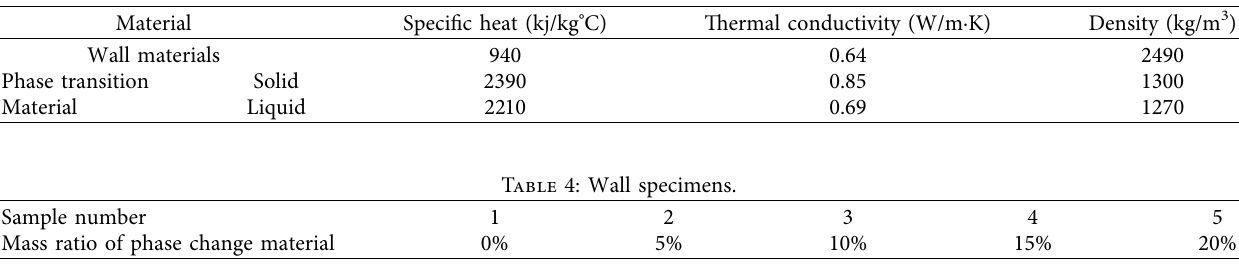
Table 3: Physical and thermal properties of each material.